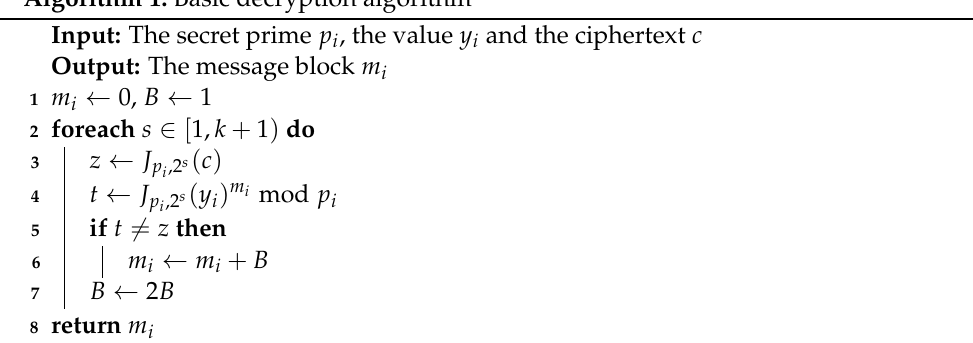
Algorithm 1: Basic decryption